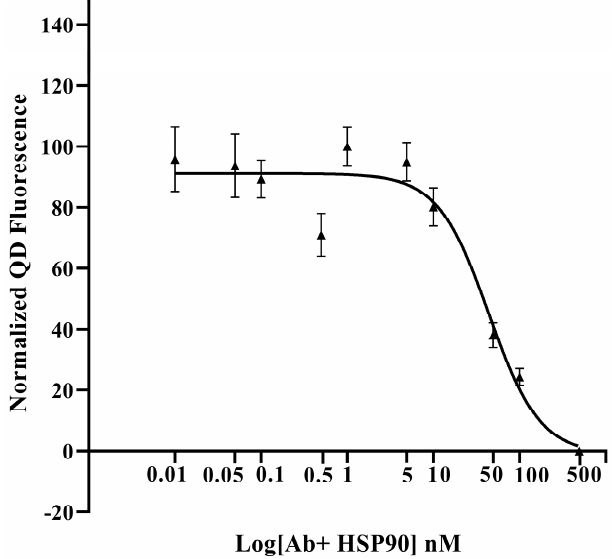
Figure 5. Masking of Sav-QDs as a function of biotin-HSP90 antibody and HSP90 α concentration. Concentration-dependent masking fitted in a dose-responsive manner with an EC 50 value of 43.96 nM. Maximum fluorescence intensity is counted as 100%, which is 0.1 nM of biotin antibody and Hsp90 α . Concentration of the Sav-QDs was 50 nM. Parameters of the dose–response fitting, A1 = 00.1 nM, A2 = 500 nM, slope = − 1.467, log X = 1.643, X = 43.96.